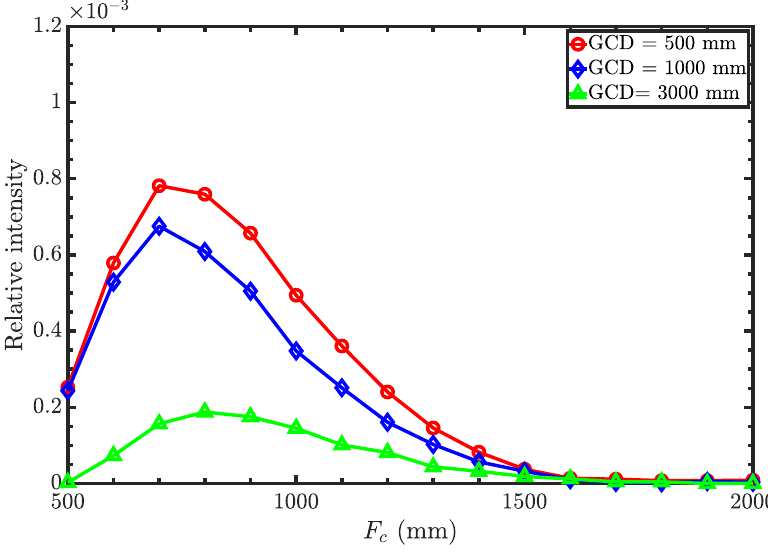
Figure 5. Relative intensity as a function of condenser focal length for three different guide-to-condenser distances (GCD) (Wolter I objective). F 0 = 750